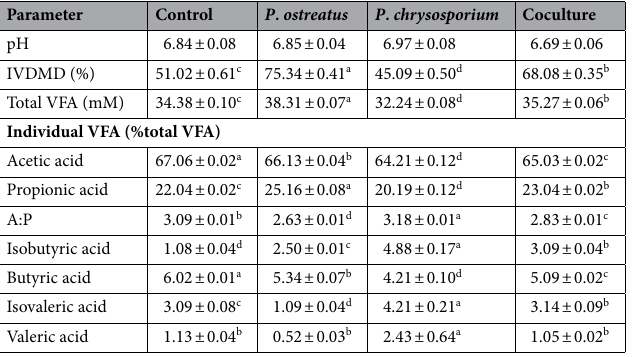
Table 2. pH, IVDMD and VFA from rice straw after incubation with axenic and coculture white-rot fungi. All values are mean ± standard error. A:P, acetate propionate ratio. a–d Values with different superscripts in a row represent significant different ( P < 0.05).